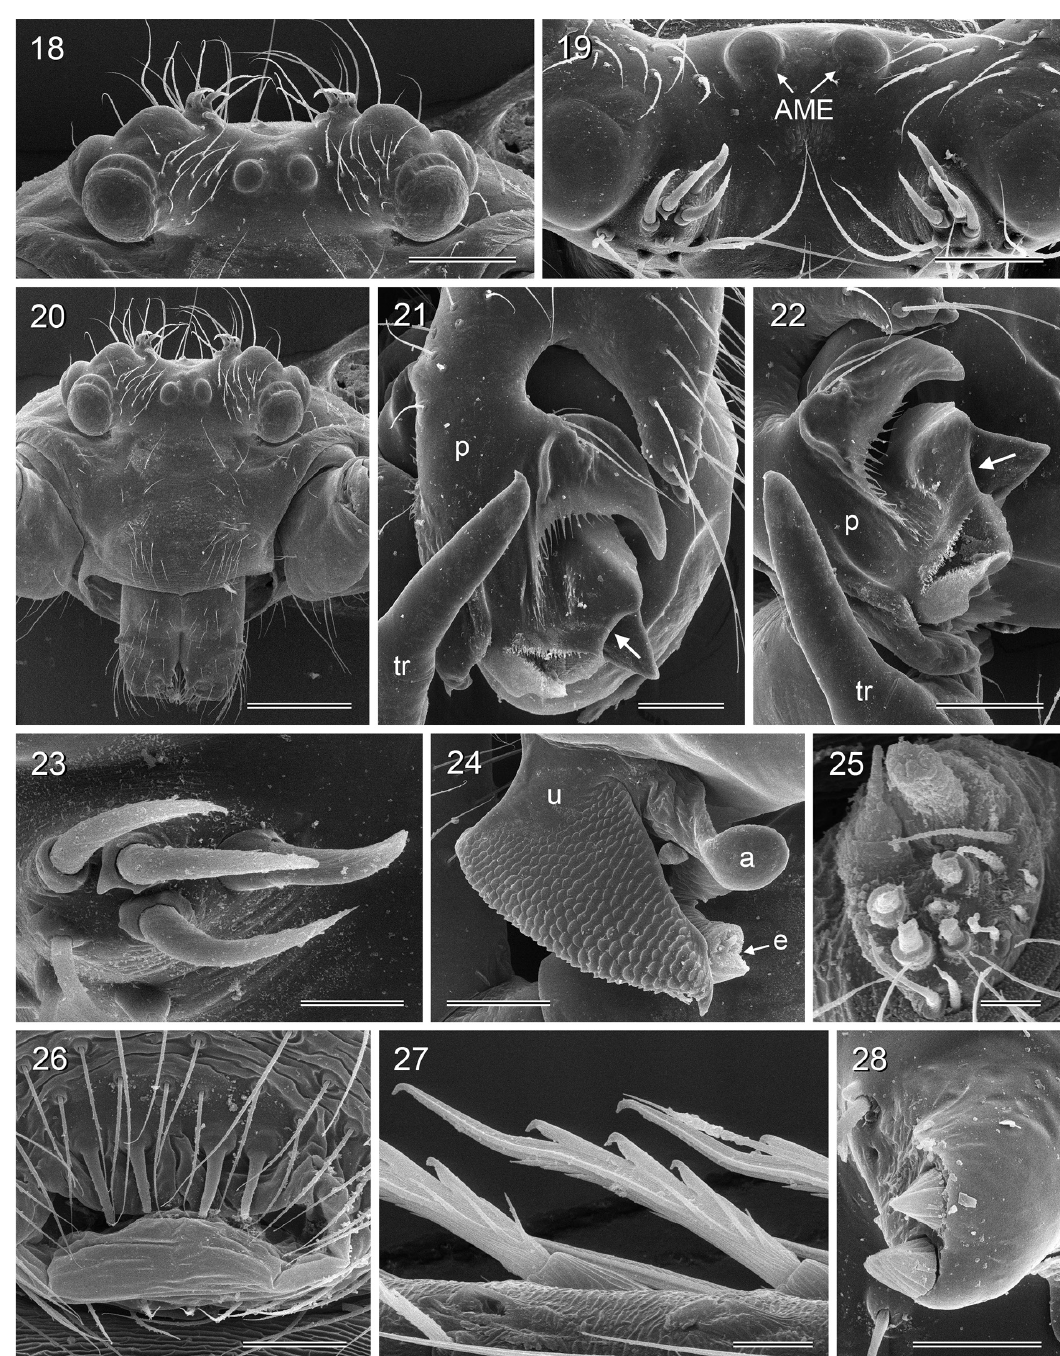
Figs 18–28. Pholcus halabala Huber, 2011, ZFMK Ar 15008. 18 . Male ocular area, frontal view. 19 . Modified hairs on male ocular area, dorsal view. 20 . Male prosoma, frontal view. 21–22 . Right procursus (and trochanter apophysis), retrolateral and retrolatero-distal views (arrows point at distal pocket). 23 . Modified hairs on male ocular area. 24 . Left bulbal processes, prolateral (slightly ventral) view. 25 . Male ALS. 26 . Male gonopore. 27 . Comb-hairs on male tarsus 4. 28 . Male distal cheliceral apophysis. Abbreviations: a = appendix; AME = anterior median eyes; e = embolus; p = procursus; tr = trochanter; u = uncus. Scale lines: 10 µm (25, 27); 20 µm (28); 30 µm (23); 40 µm (26); 80 µm (24); 100 µm (19, 21–22); 200 µm (18); 300 µm